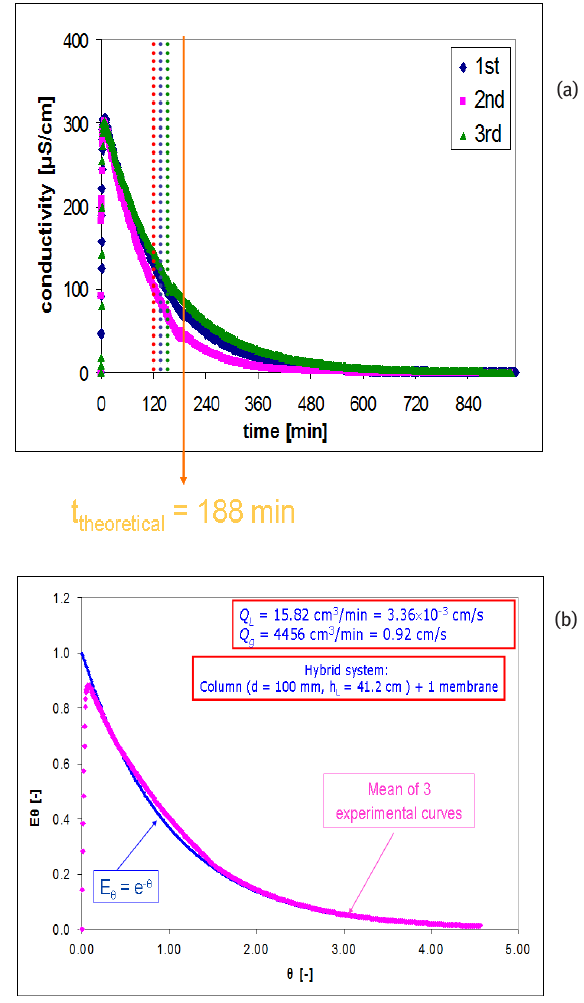
Figure 1 : (a) Conductivity measurements and (b) RTD calculations in the hybrid cell; ( L / D = 4) QL = 15.82 cm 3 min -1 , Qg = 4456 cm 3 min -1 , hL = 41.2 cm, τ = 188 min. theoretical